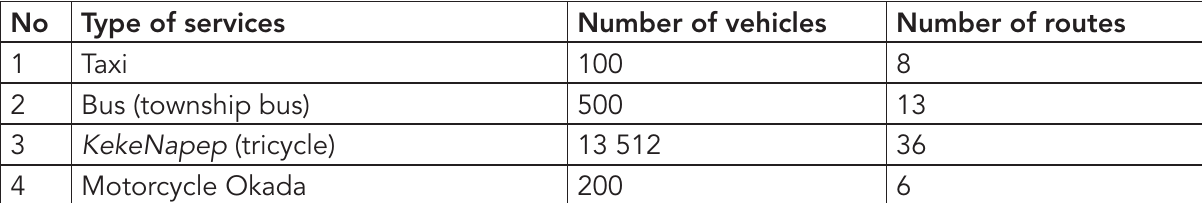
Table 1: Number of public transport vehicles in